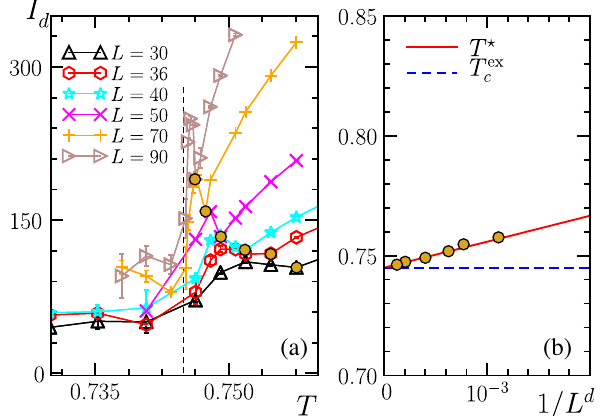
FIG. 4. First-order phase transition. Panel (a) shows I d as a function of T for the eight-state Potts model. Panel (b) shows the finite-size scaling of T (cid:4) , where d ¼ 2 (see